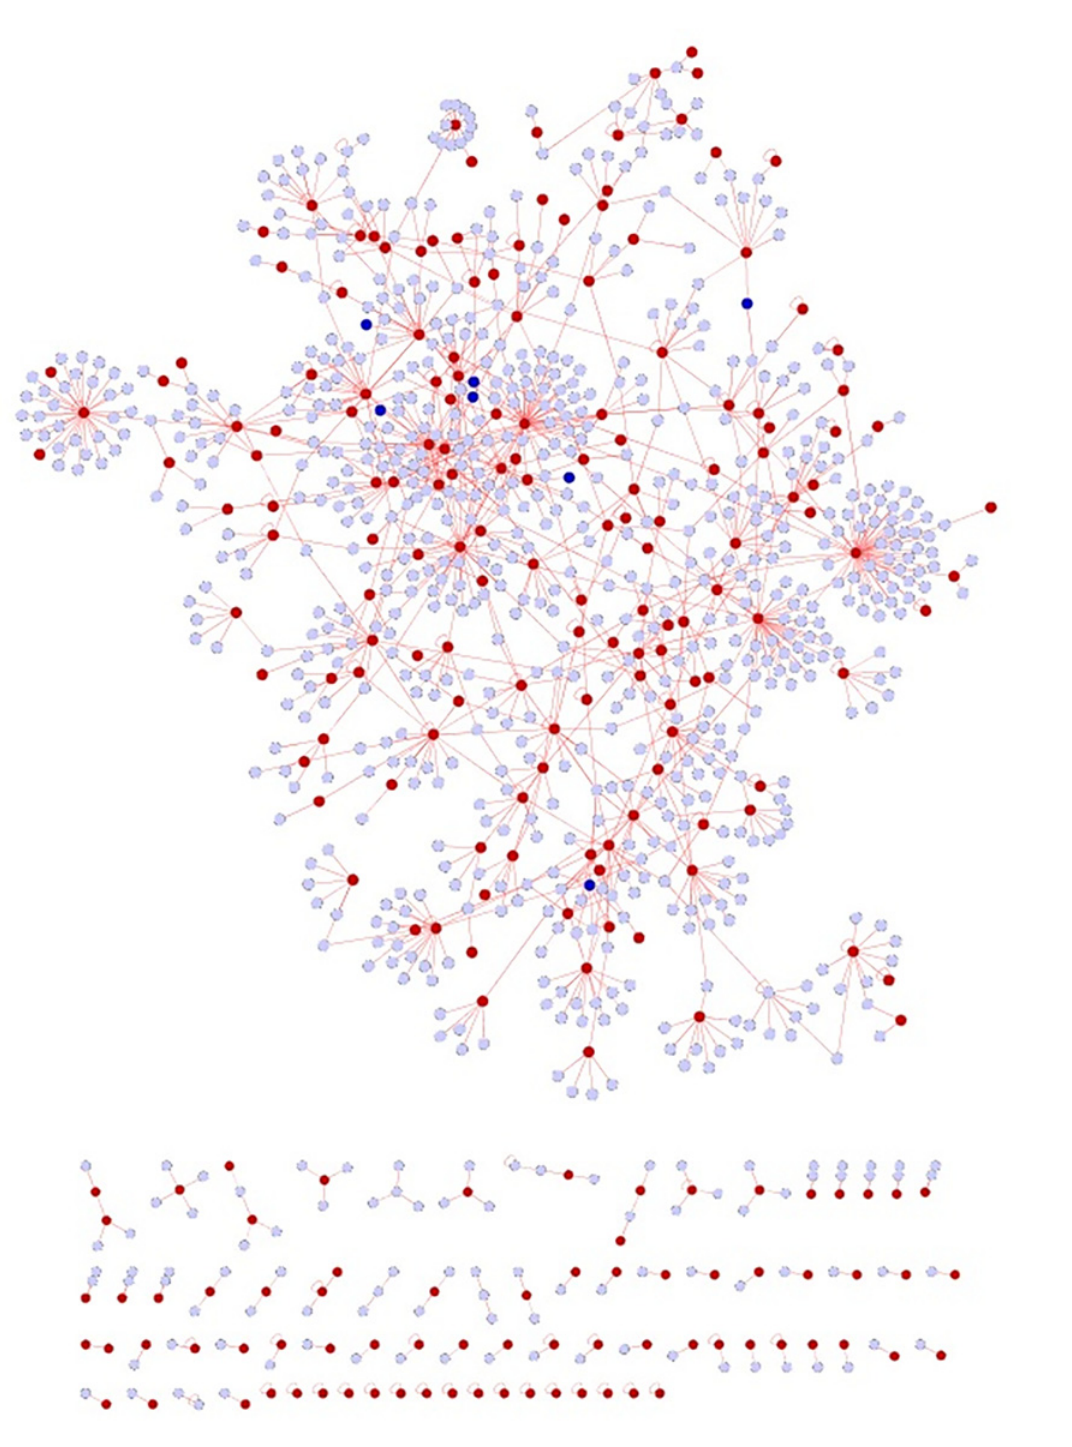
Fig 3. Psoriasis diseasome along with MI proteins. Violet nodes — proteins in psoriasis, red nodes — common proteins shared by MI and psoriasis and blue nodes — indirect interactions.